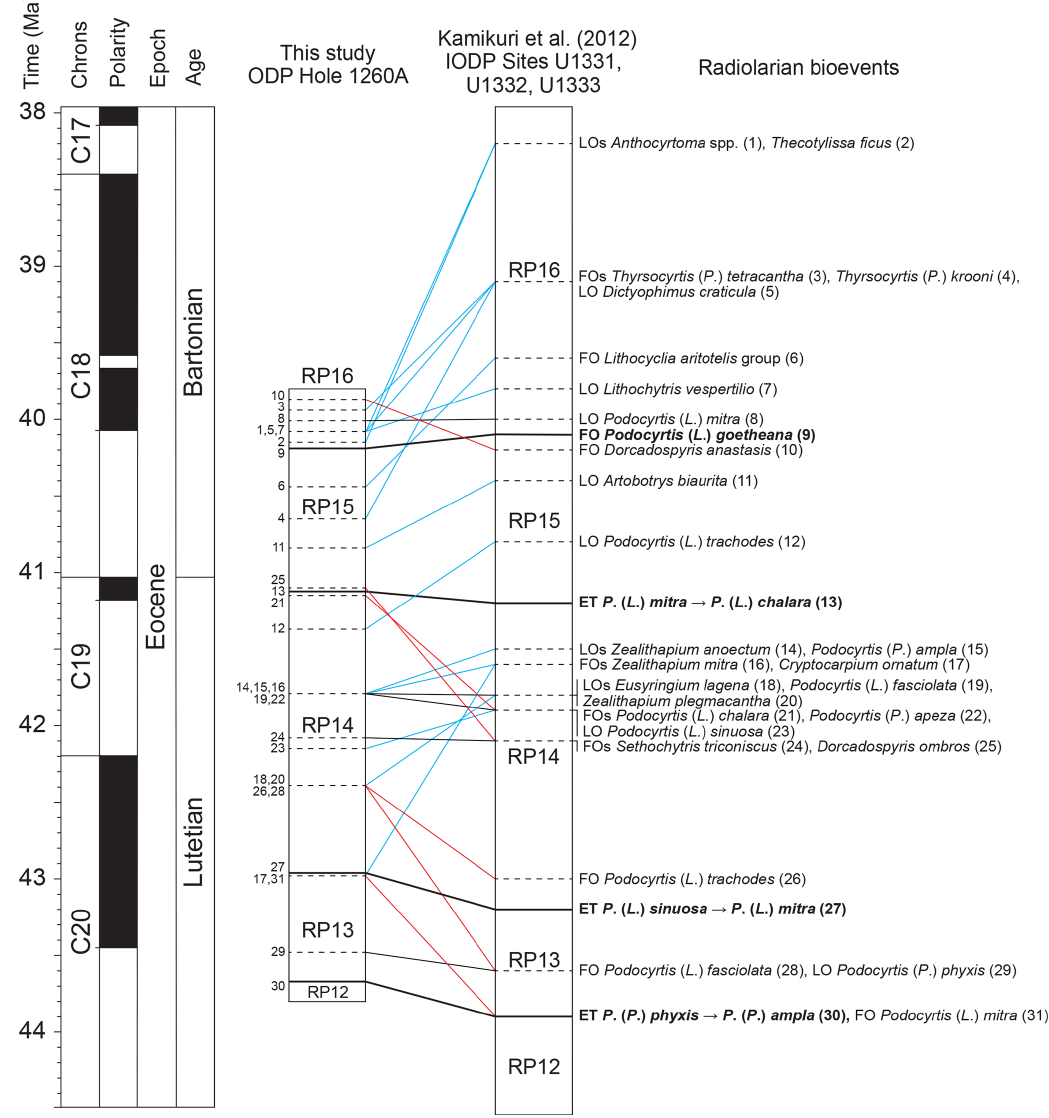
Figure 3. Correlation of radiolarian bioevents between ODP hole 1260A (this study) and IODP Sites U1331, U1332, and U1333 (Kamikuri et al., 2012). Black lines represent nearly synchronous bioevents, blue lines represent diachronous bioevents which first occur in the Atlantic Ocean, and red lines represent diachronous bioevents which first occur in the Pacific Ocean. The geomagnetic timescale is after Speijer et al.